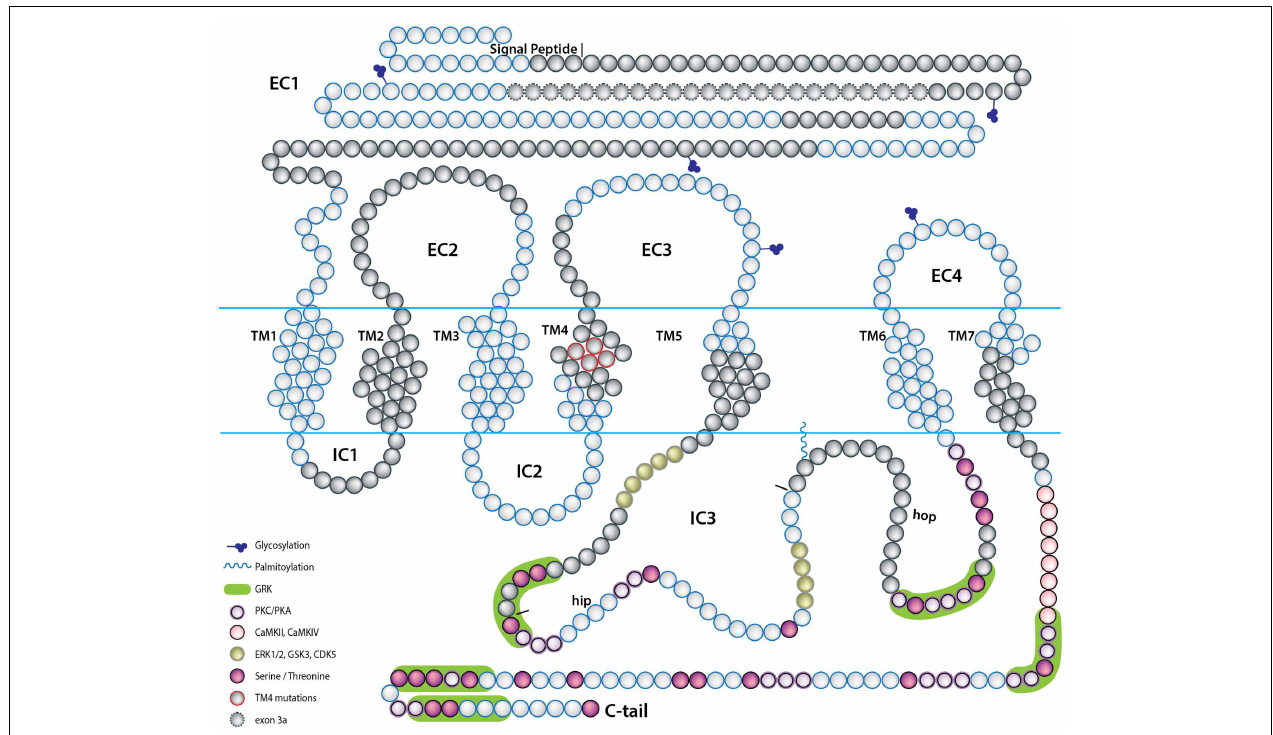
PAC1 signaling are marked on the protein diagram with regard to putative motifs formed due to insertions of hop and hip cassettes into the IC3 loop sequence. EC, extracellular loop; IC, intracellular loop;TM, transmembrane